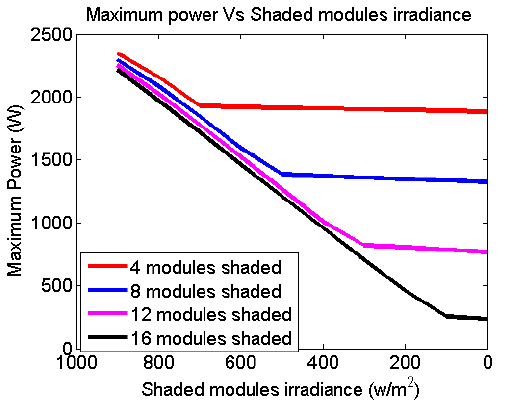
Figure 13. Maximum power versus shaded modules irradiance (all experiment setups).